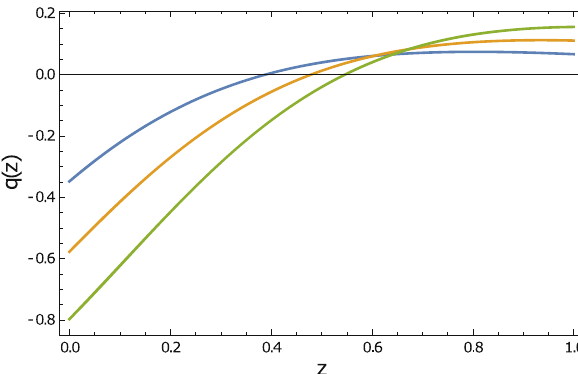
Fig. 6 Deceleration parameter, q , as a function of redshift for jerk parameter in Eq. (48); Blue is s = 0 . 8, Yellow is s = 1 . 0 and Green is s = 1 . 2. m and n take the same values as in Fig.